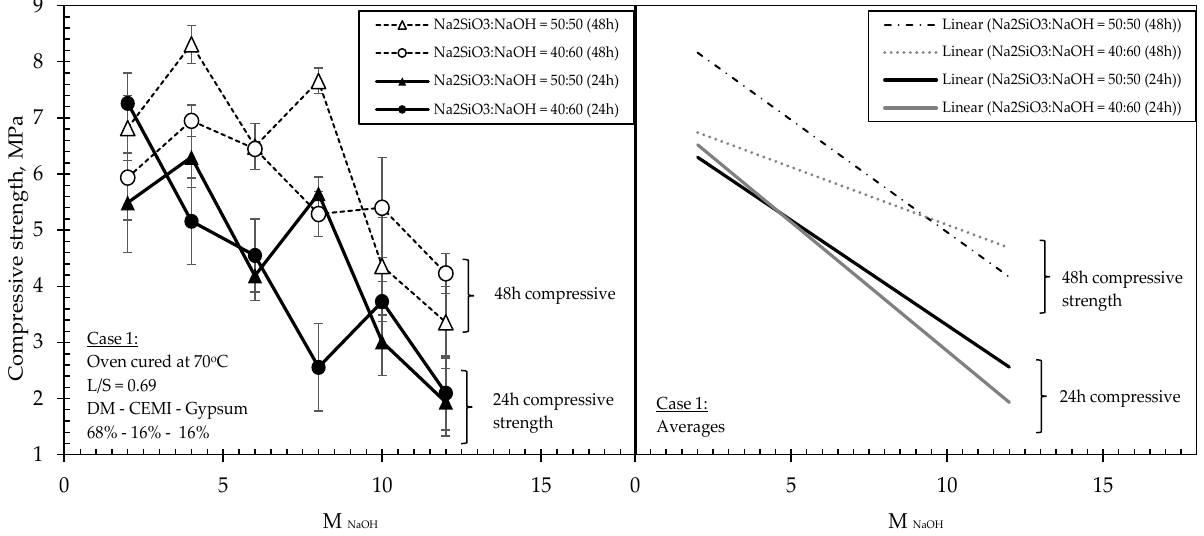
Figure 4. Effect of molarity of NaOH on the 24 h and 48 h compressive strength of formulations investigated in Case 1.